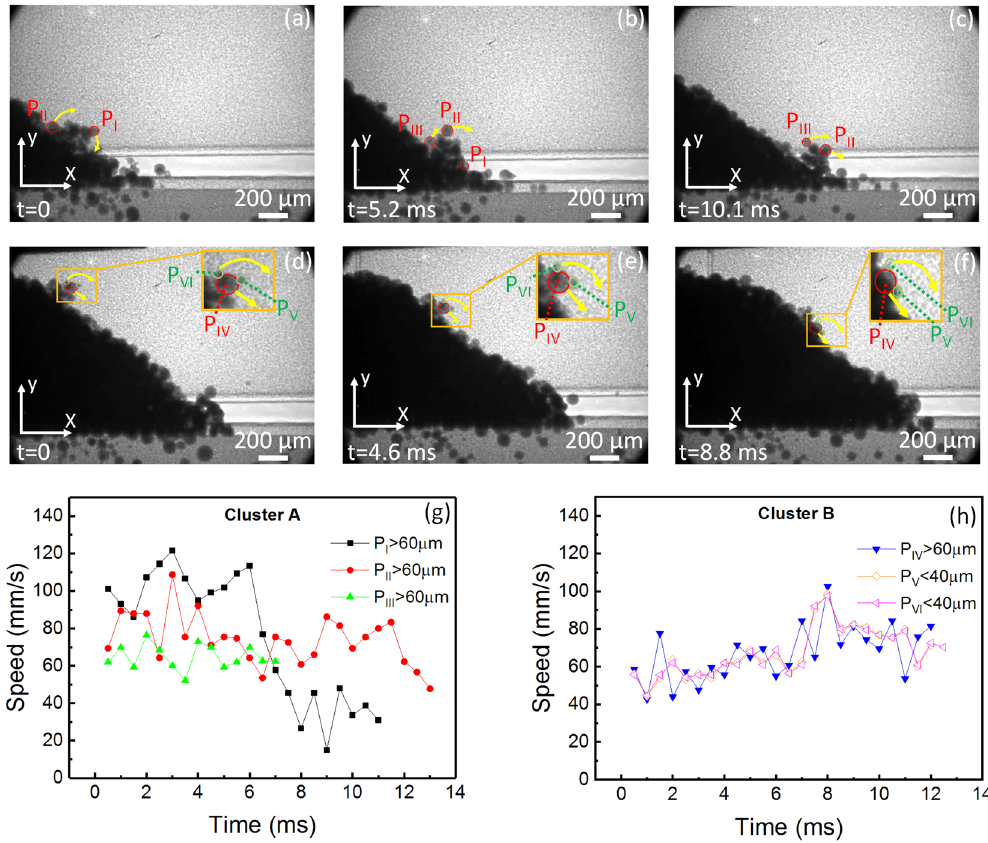
Figure 7. Tracking of individual particles of different sizes within the powder clusters during the spreading of 316 L stainless steel powder with an average diameter of 67 µ m. ( a – c ) Dynamic x-ray images showing the motion of particles P I , P II and P III within the soft powder cluster “A”. ( d – f ) Dynamic x-ray images showing the motion of particles P IV , P V and P VI within the hard powder cluster “B”. Yellow arrows show the translational and rotational trajectory of the powders. The position versus time was tracked with reference to the origin of the coordinate system in the pictures. ( g ) Speed over time for particles within “cluster A”. ( h ) Speed over time for particles within “cluster B”.